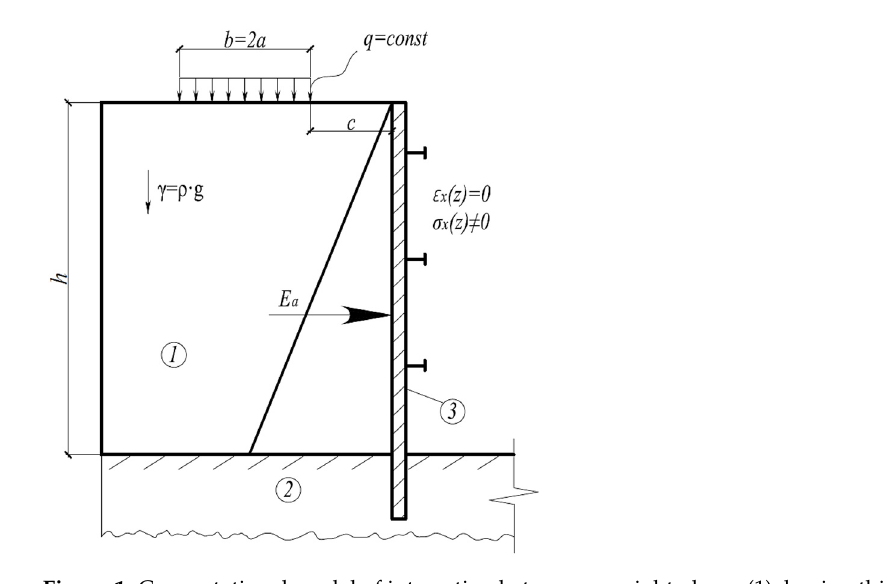
Figure 1. Computational model of interaction between a weighty layer (1), having thickness ( h ) and resting on an incompressible soil base (2), with a vertical fixed wall of an excavation pit enclosure (3) subjected to a distributed loading q = const along strip b = 2 a at a distance ( c ) from the enclosure.